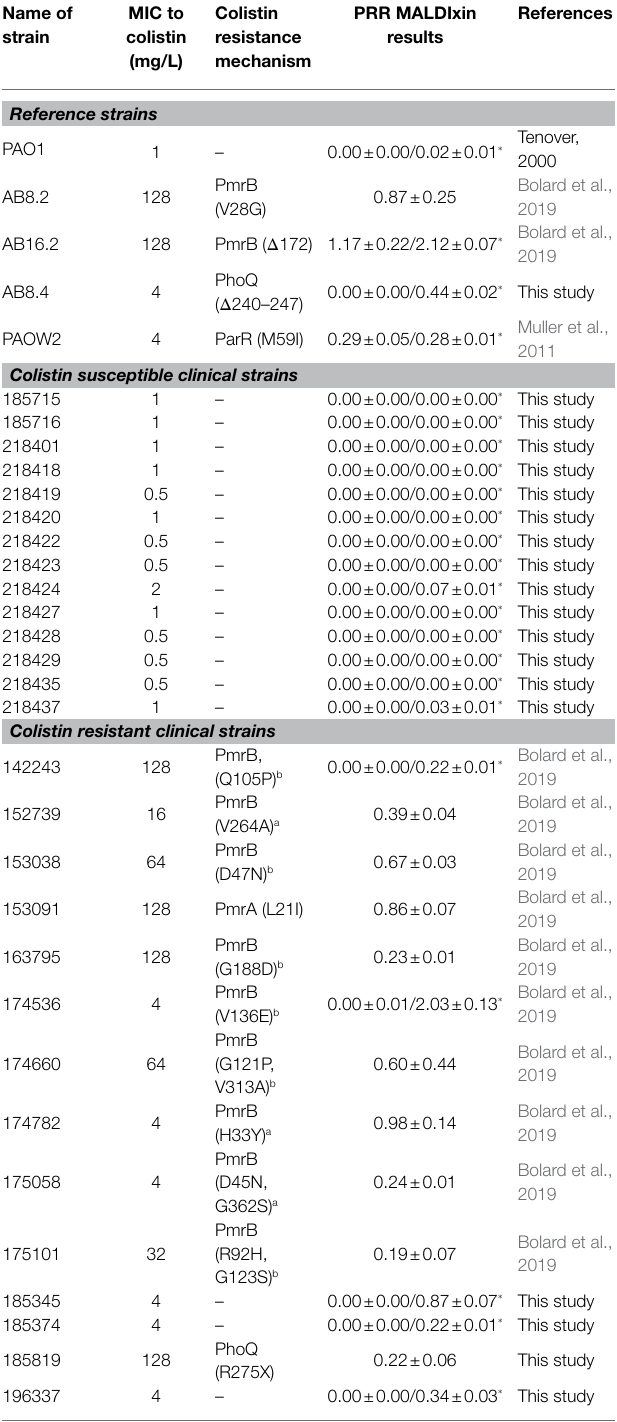
TABLE 1 | Characteristics and results of the MALDIxin test on P. aeruginosa